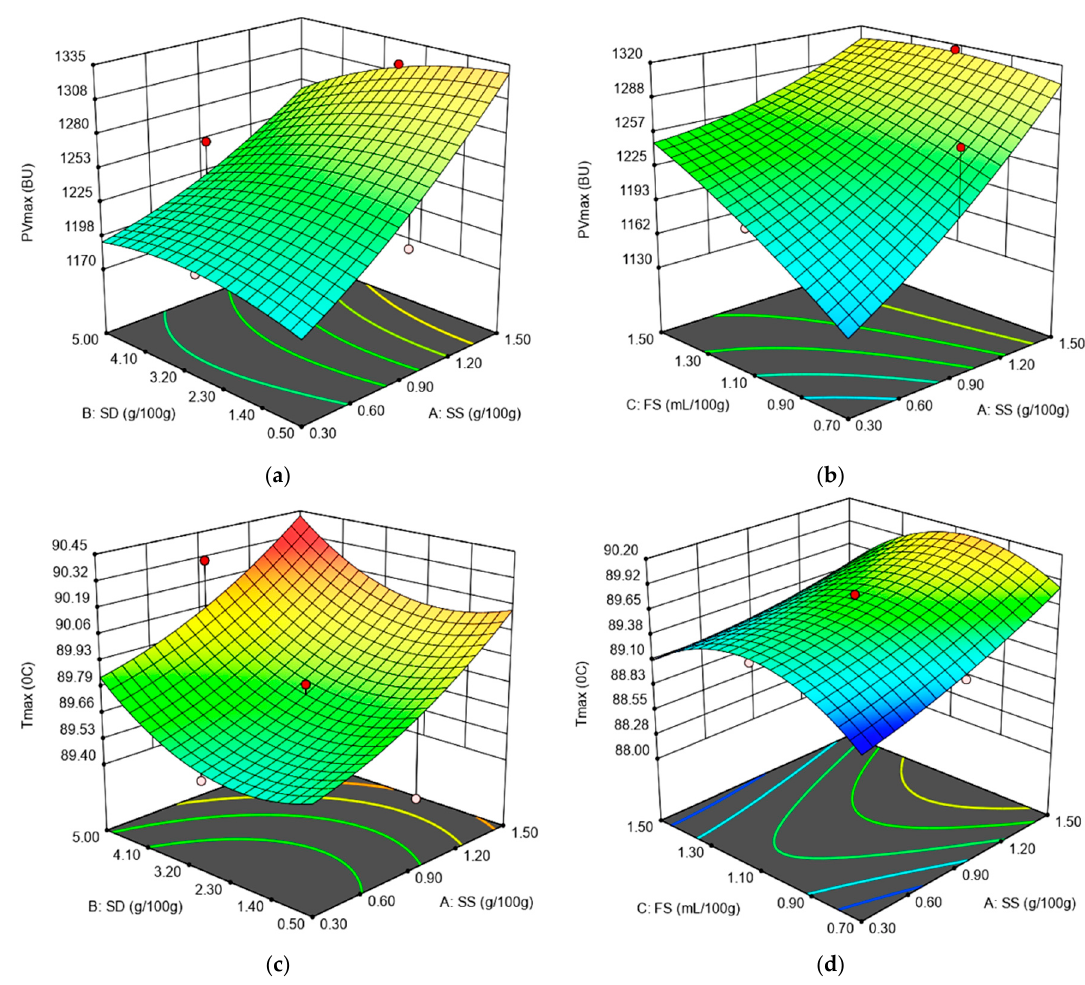
Figure 3. Graphical representations of the Amylograph parameters: ( a ) peak viscosity (PV max ) as affected by the levels of sea salt (SS) and dry sourdough (SD) incorporated in wheat flour at 1.10 (mL/100 g) fermented sugar; ( b ) peak viscosity (PV max ) as affected by the levels of sea salt (SS) and fermented sugar (FS) incorporated in wheat flour at 2.75 (g/100 g) dry sourdough; ( c ) temperature at peak viscosity (T max ) as affected by the levels of sea salt (SS) and dry sourdough (SD) incorporated in wheat flour at 1.10 (mL/100 g) fermented sugar; ( d ) temperature at peak viscosity (T max ) as affected by the levels of sea salt (SS) and fermented sugar (FS) incorporated in wheat flour at 2.75 (g/100 g) dry sourdough.